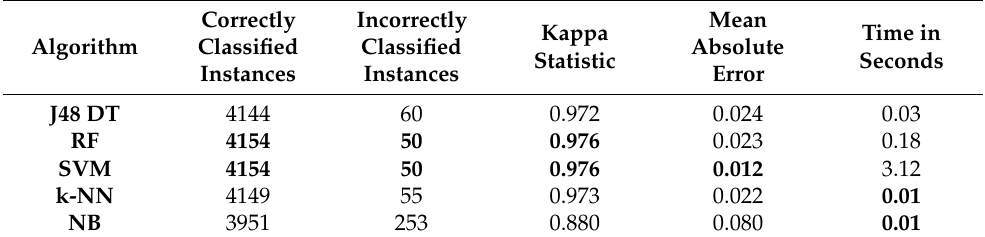
Table 10. Supervised machine learning algorithms’ performance with Kaggle’s COVID-19 Symptoms and Presence dataset using tuned